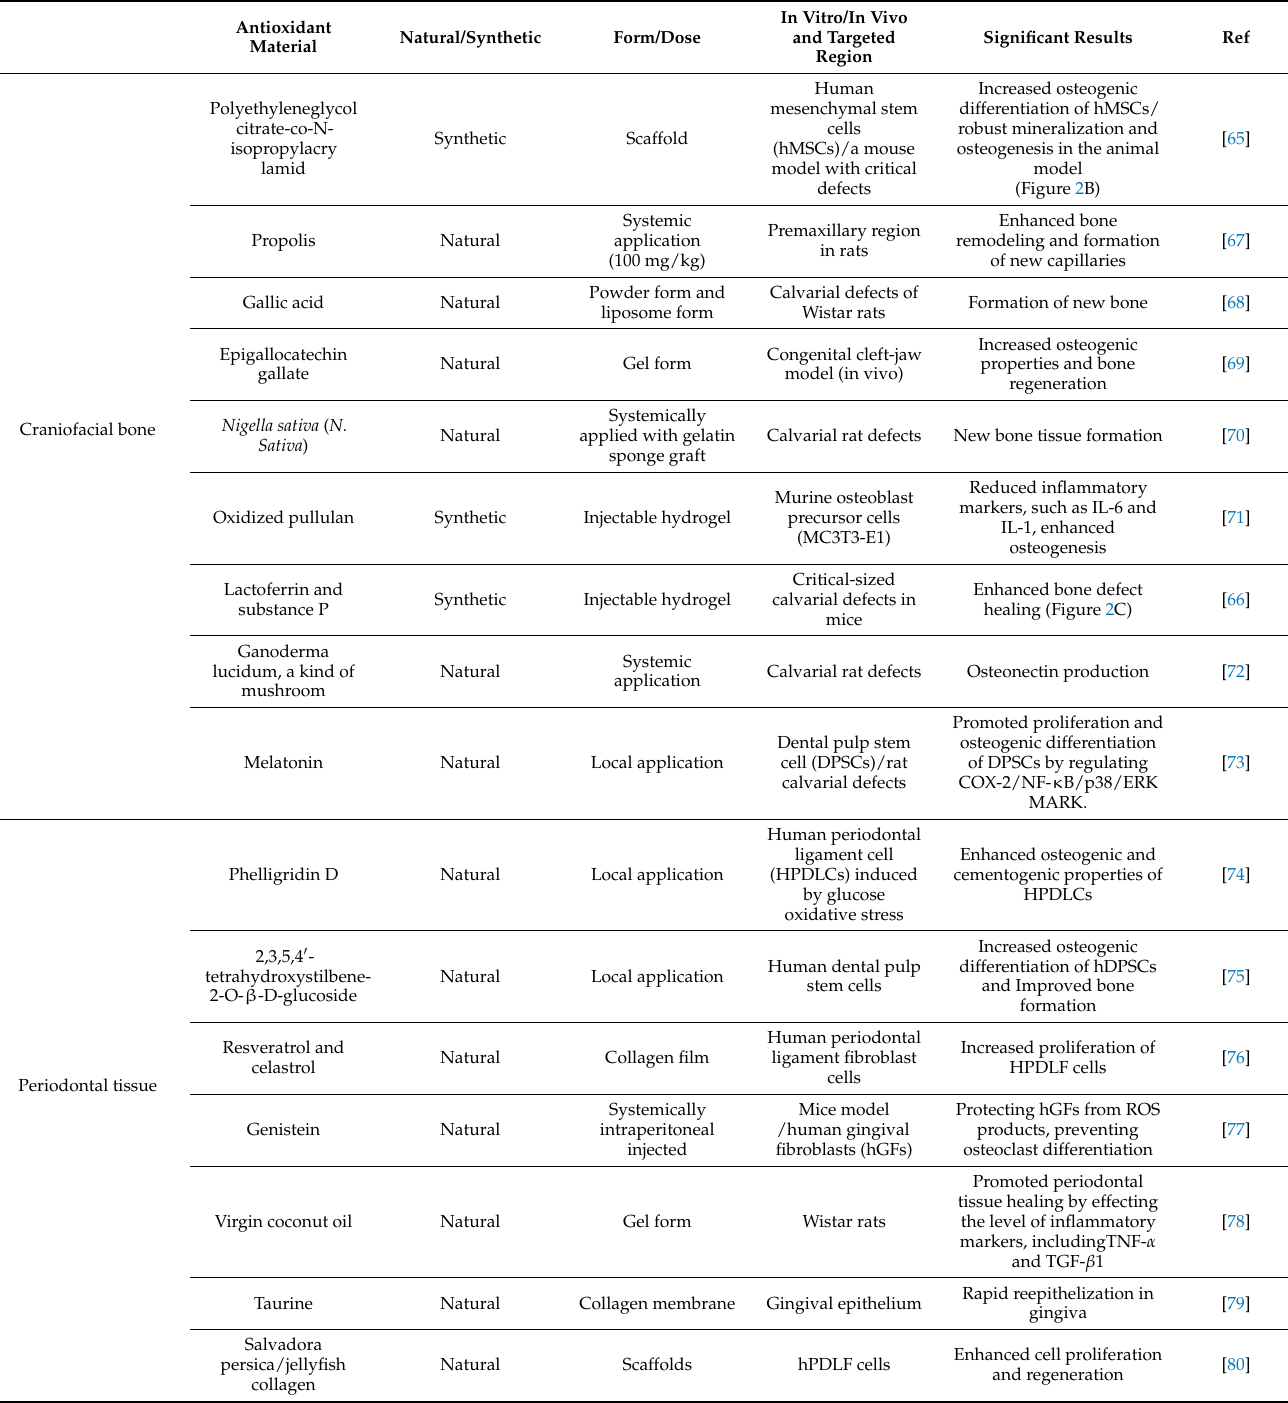
Table 1. The studies reported on the application of antioxidant materials for oral and maxillofacial tissue